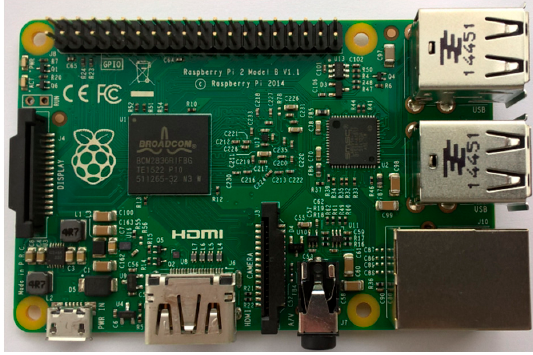
Figure 1. Raspberry Pi 2 Model B.